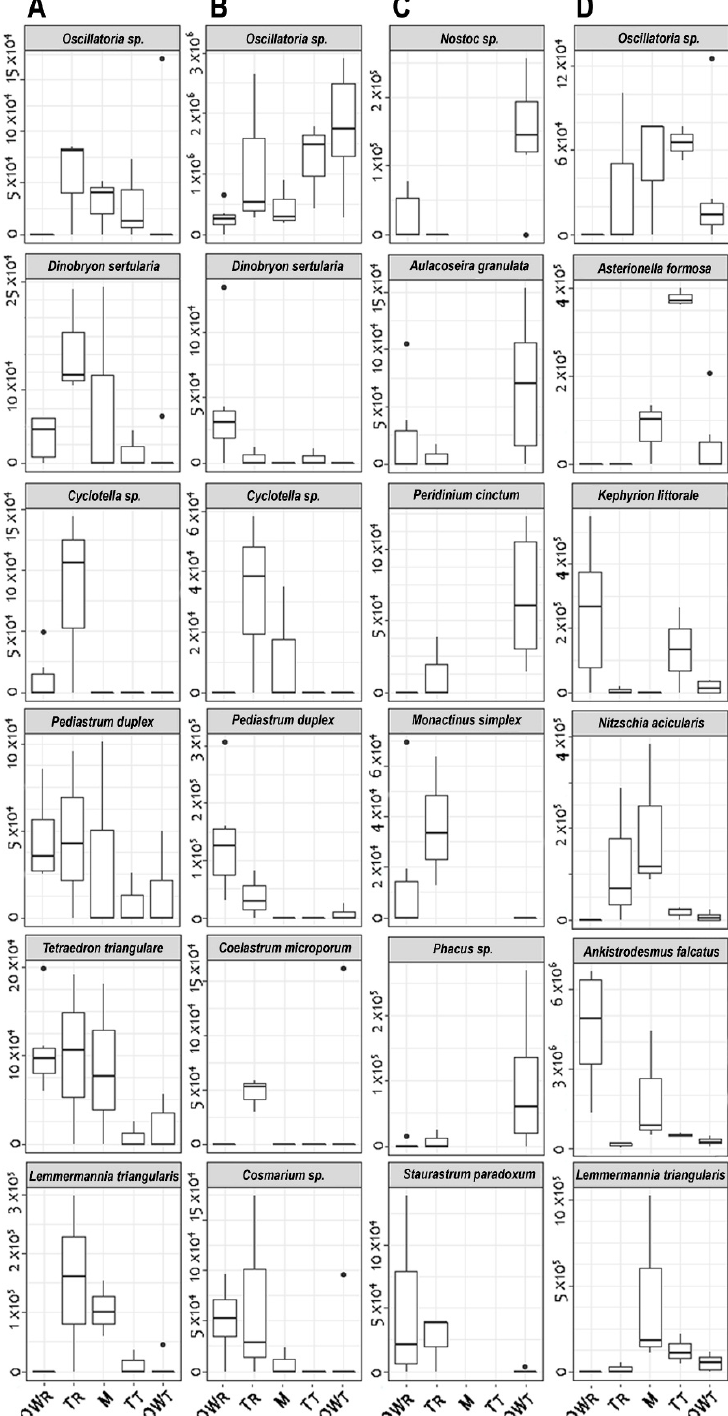
Figure 4. Boxplot of the most characteristic algal plankton species considered to have the highest abundance in the PCA at each transect. Graph ( A ): April, Graph ( B ): June, Graph ( C ): July, Graph ( D ): October. Rakamaz open water zone: OW R ; Rakamaz transitional zone: T R ; Middle zone: M; Tiszanagyfalu transitional zone: T T ; Tiszanagyfalu open water zone: OW T .